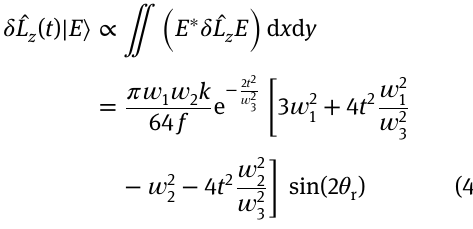
Figure 1: Conceptual sketch to show the tilt angle 𝜃 with transverse OAM, 𝜃 be some arbitrary value, x – y is the transverse